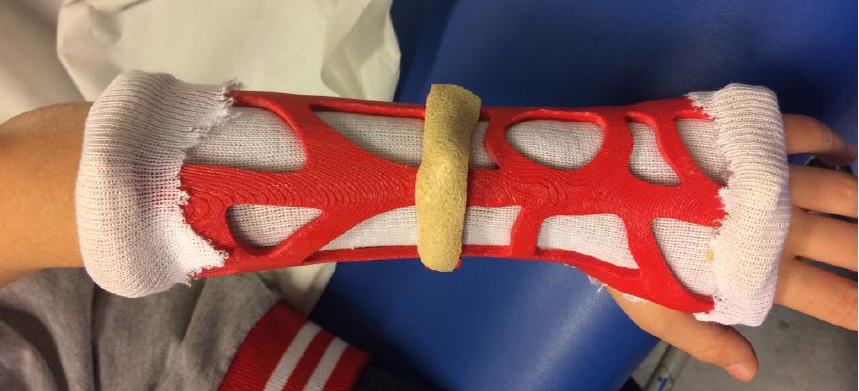
Figure 4. The 3D-printed orthosis positioned.